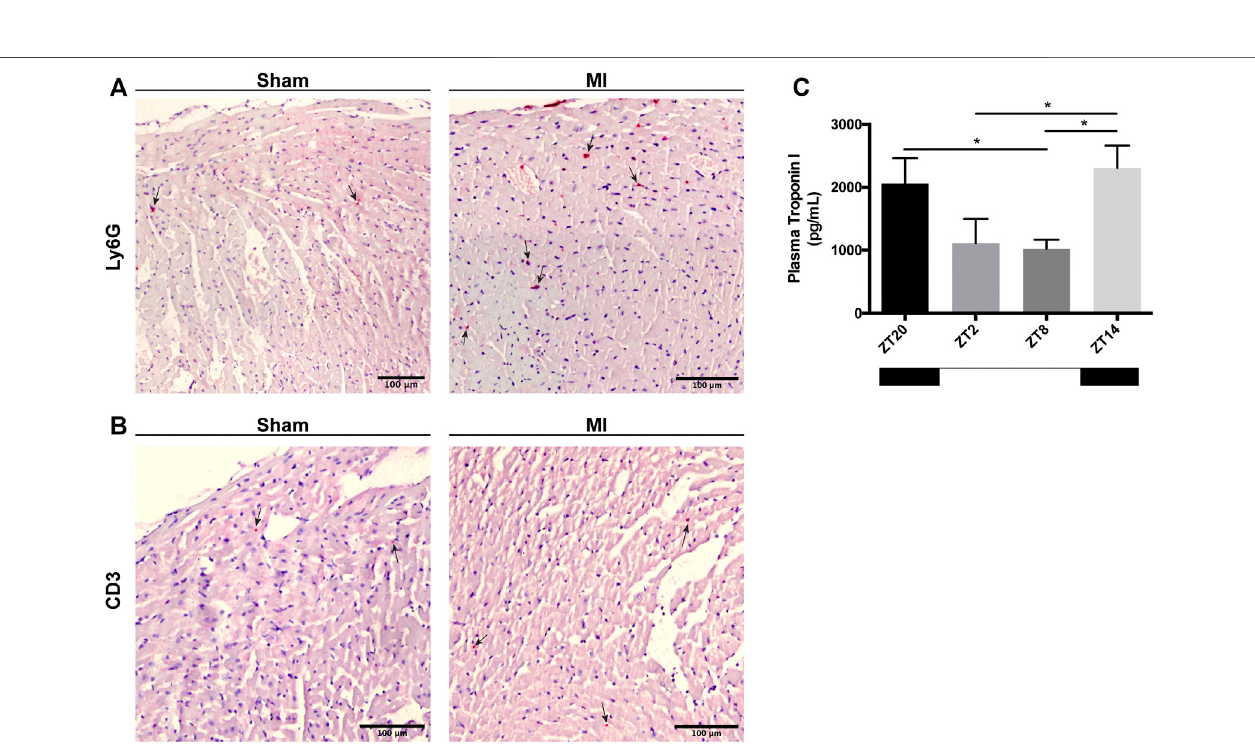
FIGURE 3 | Immune cell in fi ltration in the heart and cardiac damage 3 h after MI induction. (A) Representative images showing Ly6G + neutrophils in the myocardium (black arrows; scale bar: 100 μ m). (B) Representative images showing CD3 + T-cells in the myocardium ( black arrows; scale bar: 100 µm). (C) Troponin-I levels in the plasma ofmice subjected toMI at ZT2, ZT8, ZT14 and ZT20, 3 h after injury. ( n = 5 – 6 per group for all experiments) ( *p < 0.05 byone-way ANOVA withLSD test).